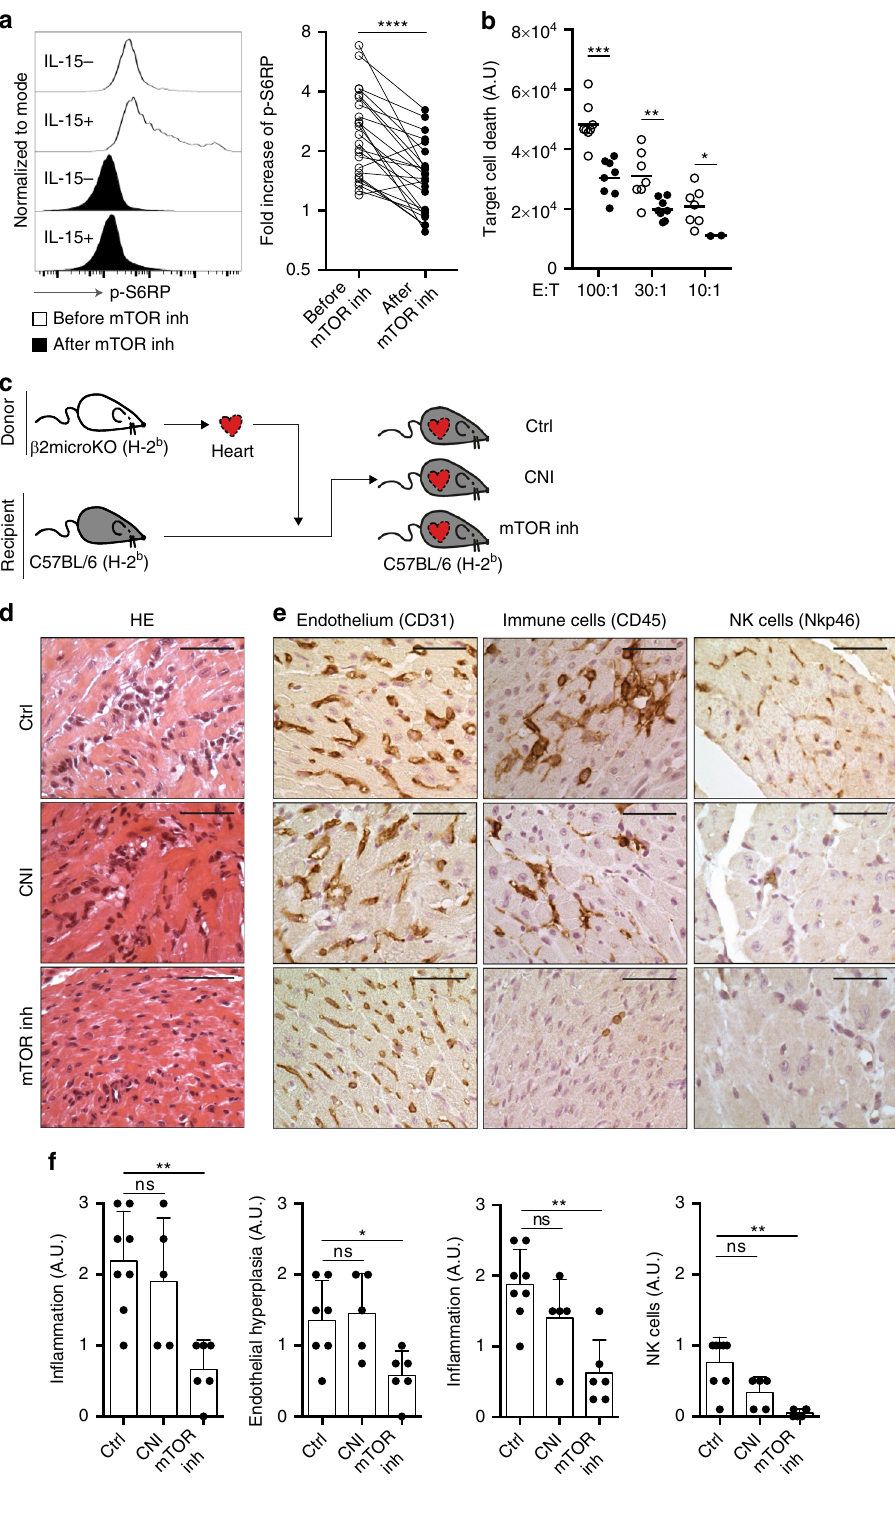
performed by indirect immuno fl uorescence on frozen sections using an anti- human C4d complement-rabbit clonal antibody (clone A24-T, produced by DB Biotech, Kosice, Slovak Republic). The renal pathologist (M. Rabeyrin) who reviewed the biopsy specimens was blinded to clinical and immunological